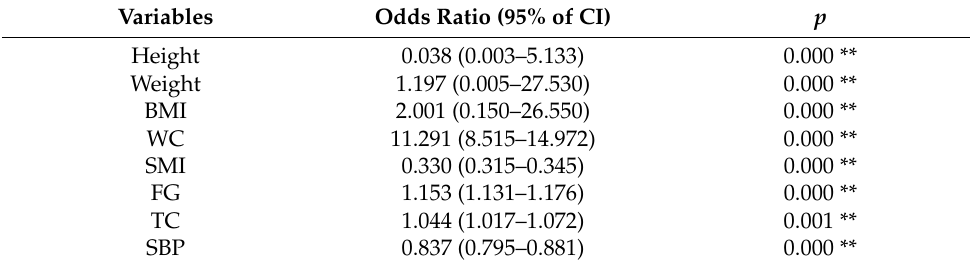
Table 5. Odds ratios for SO in